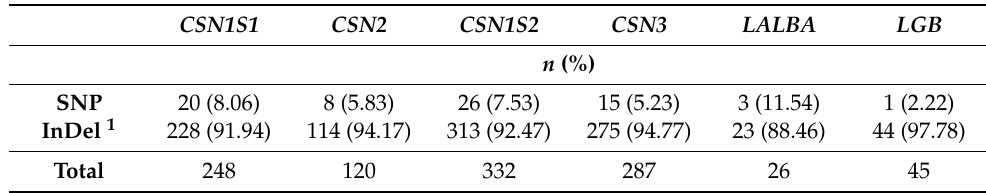
Table 2. Number and percentage distribution (in brackets) of the sequence variants (SNP, InDel) detected within the exon sequences, flanking intron sequences and parts of the 5 (cid:48) -flanking region of the six milk protein genes ( CSN1S1 , CSN2 , CSN1S2 , CSN3 , LALBA , LGB ) in Beninese indigenous cattle breeds.